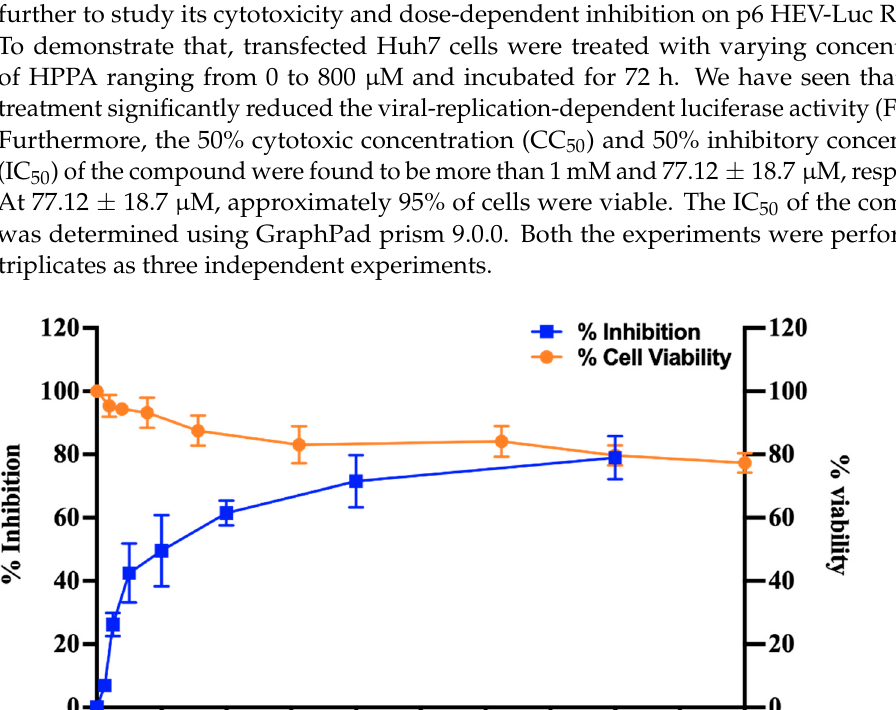
Figure 7. Molecular dynamics simulations of HPPA with HEV-MTase: RMSD of the C α backbone of apo-MTase and its complexes with respect to time (100 ns), RMSD of compounds over 100 ns, RMSF of Ca atoms of MTase complexes over the 100 ns. Stability of MTase from HEV-MTase: The number of hydrogen bond interactions between MTase and compounds during simulation are shown. The radius of gyration (Rg) of MTase and in complex with compounds over the simulation. Total solvent accessible area (SASA) with respect to time is shown. The apo-MTase (black) and its complex with inhibitor HPPA (red) are represented.